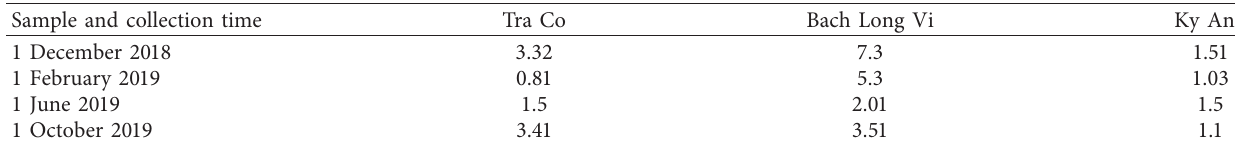
Table 5: Organic carbon content (%) at study areas.